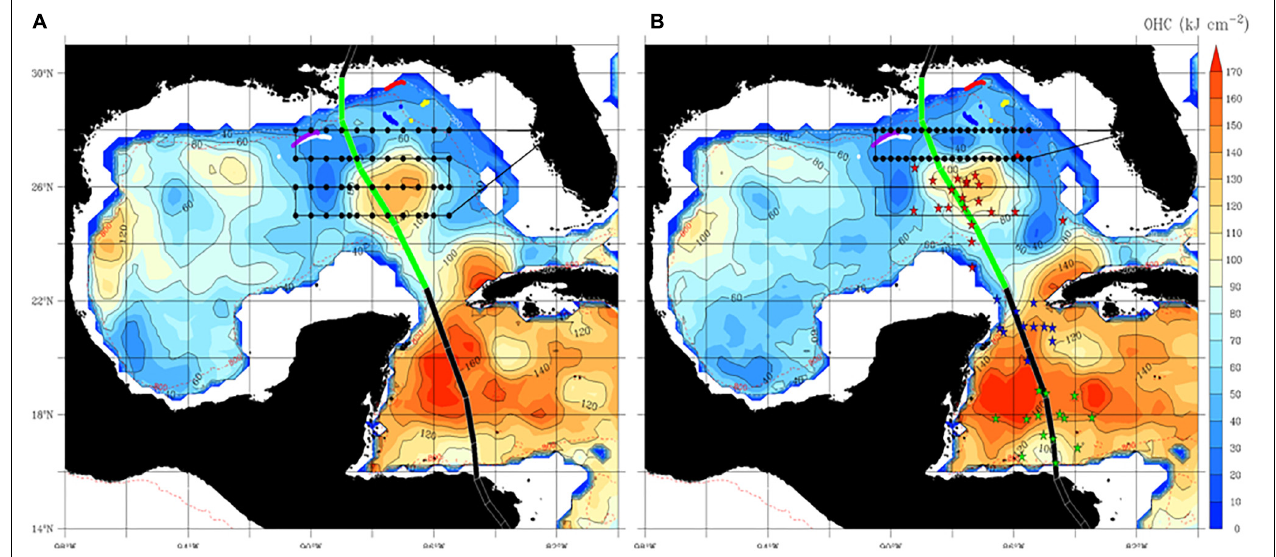
FIGURE 9 | The separation of a LC warm core eddy during the passage of Hurricane Nate of 2017. The color scale is for OHC relative to the 26 ◦ C isotherm, from the satellite fields (Meyers et al., 2014). APEX-EM floats (purple, white, red, and yellow dots) that were active during Nate’s passage of Nate over the Gulf. (A) Pre-storm OHC structure on 5 October, 2017. (B) Post-storm OHC structure on 10 October, 2017. Black dots in (A,B) depict airborne ocean profilers deployed from NOAA WP-3D research aircraft; green, blue, and red stars in (B) represent in-storm oceanographic and atmospheric airborne